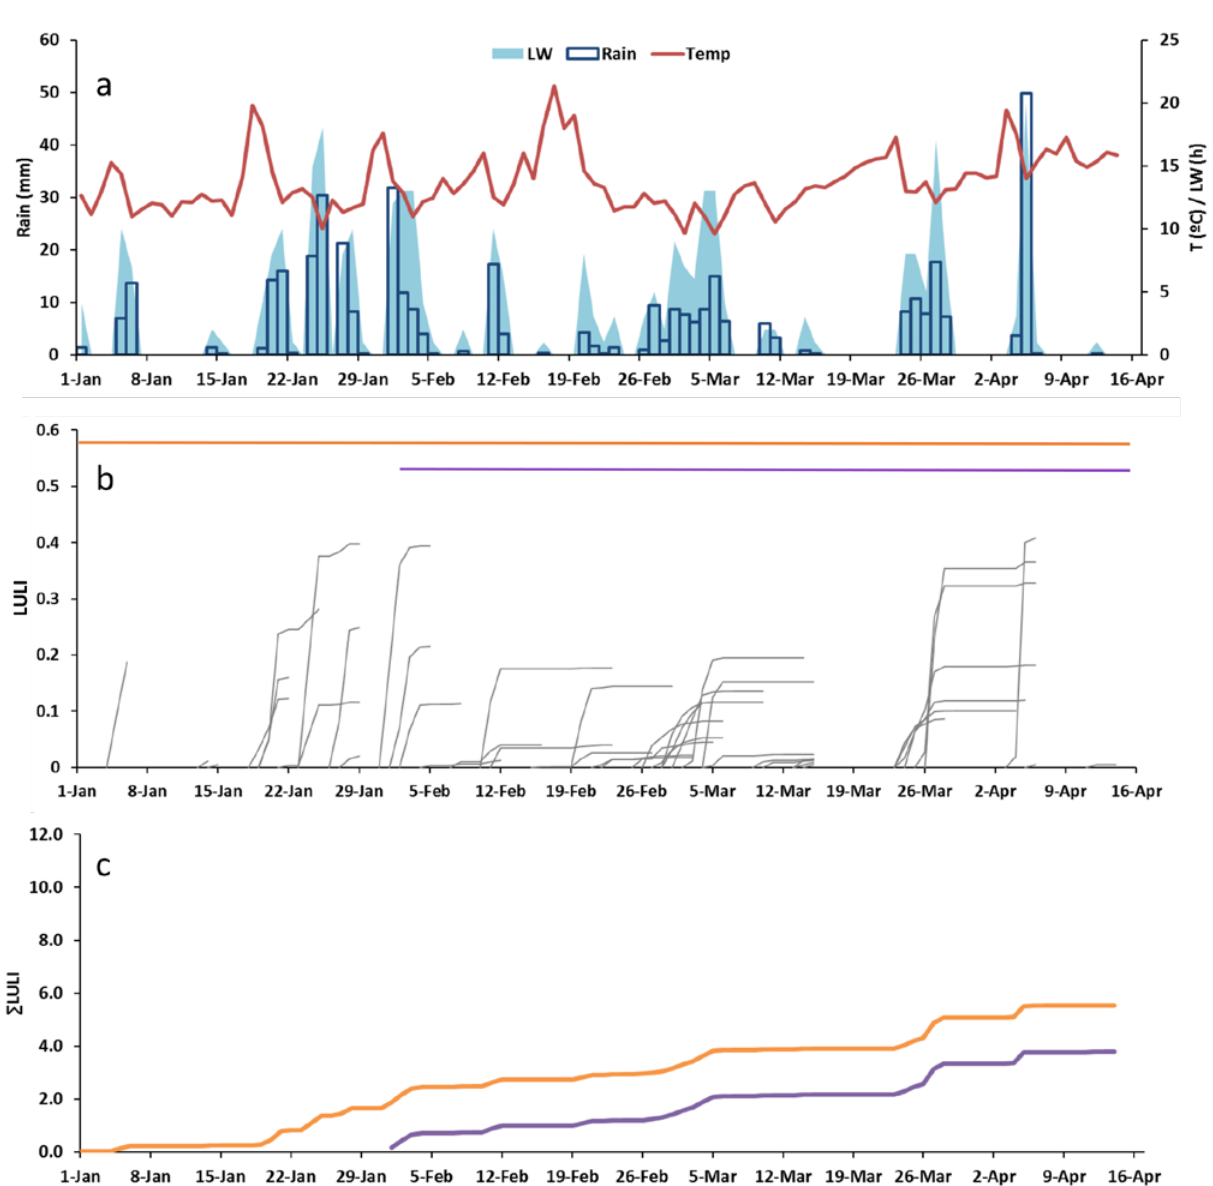
Figure 2. Weather data and model output for 2014. a: daily weather data; b: predicted increase of latent infections (LULI) for each infection period; c: predicted seasonal dynamics of the cumulative values of LULI (∑LULI) for cv. Peluche and Algerie (orange line) and for cv. San Filipparo (purple line). Coloured lines at the top in b represent the periods in which the model was operated for cv. Peluche and Algerie (orange line) and for cv. San Filipparo (purple